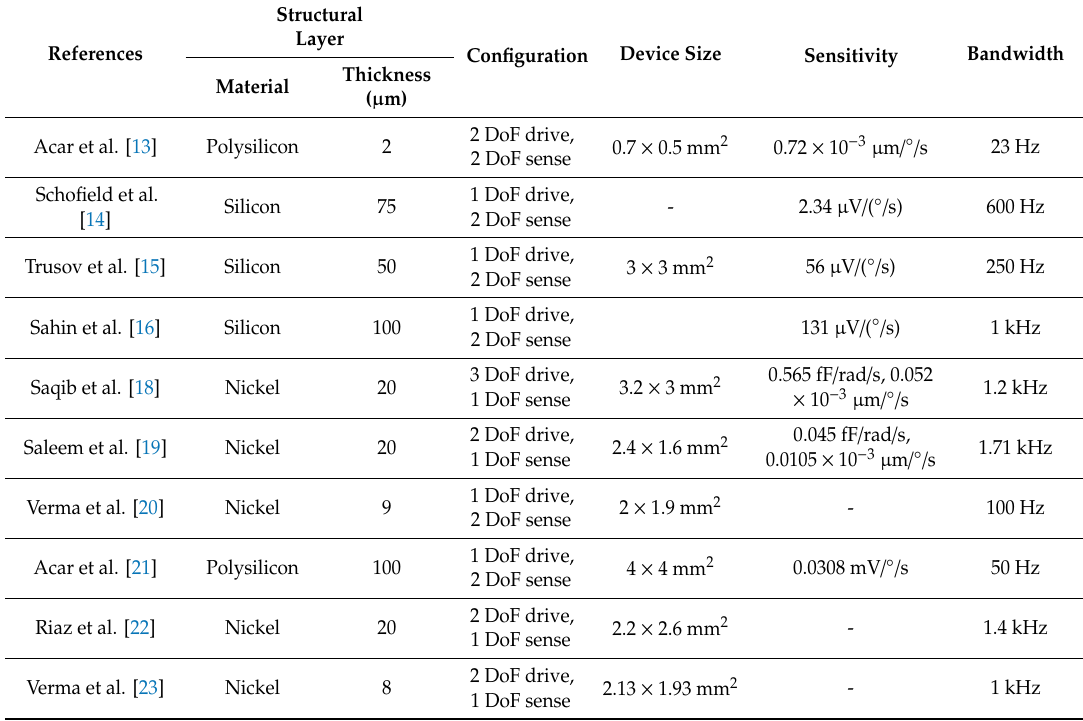
Table 1. Multi-degree of freedom (multi-DoF) non-resonant microelectromechanical systems (MEMS) gyroscopes presented in the